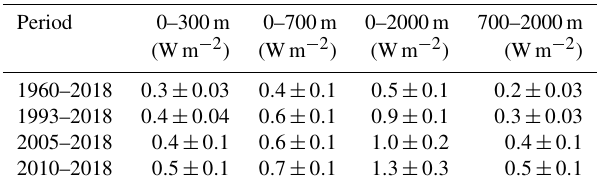
Table 1. Linear trends (weighted least square fit; see for example von Schuckmann and Le Traon, 2011) as derived from the ensemble mean as presented in Fig. 1 for different time intervals, as well as different integration depth. The uncertainty on the trend estimate is given for the 95% confidence level. Note that values are given for the ocean surface area between 60 ◦ S and 60 ◦ N and are limited to the 300m bathymetry of each product. See text and Fig. 1 caption for more details on the OHC